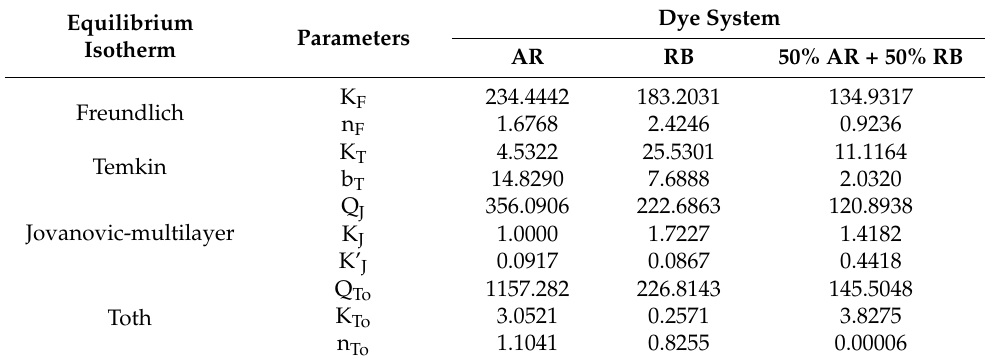
Table 5. Equilibrium isotherm parameters of adsorption of AR, RB, and 50% AR + 50%